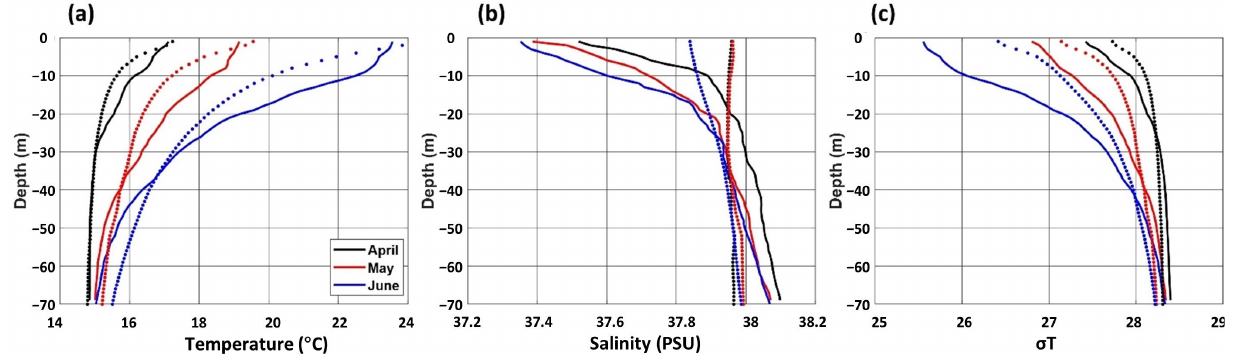
Figure 9. Monthly mean vertical profiles of T ( a ), S ( b ) and ρ ( c ) at LTER ‐ MC sampling site for April (red line), May (blue line) and June (black line) 2016. Dashed lines are the simulated vertical profiles over 37 grid point of Figure 8l. Table 10. Maximum error difference between observed and simulated hydrological data.